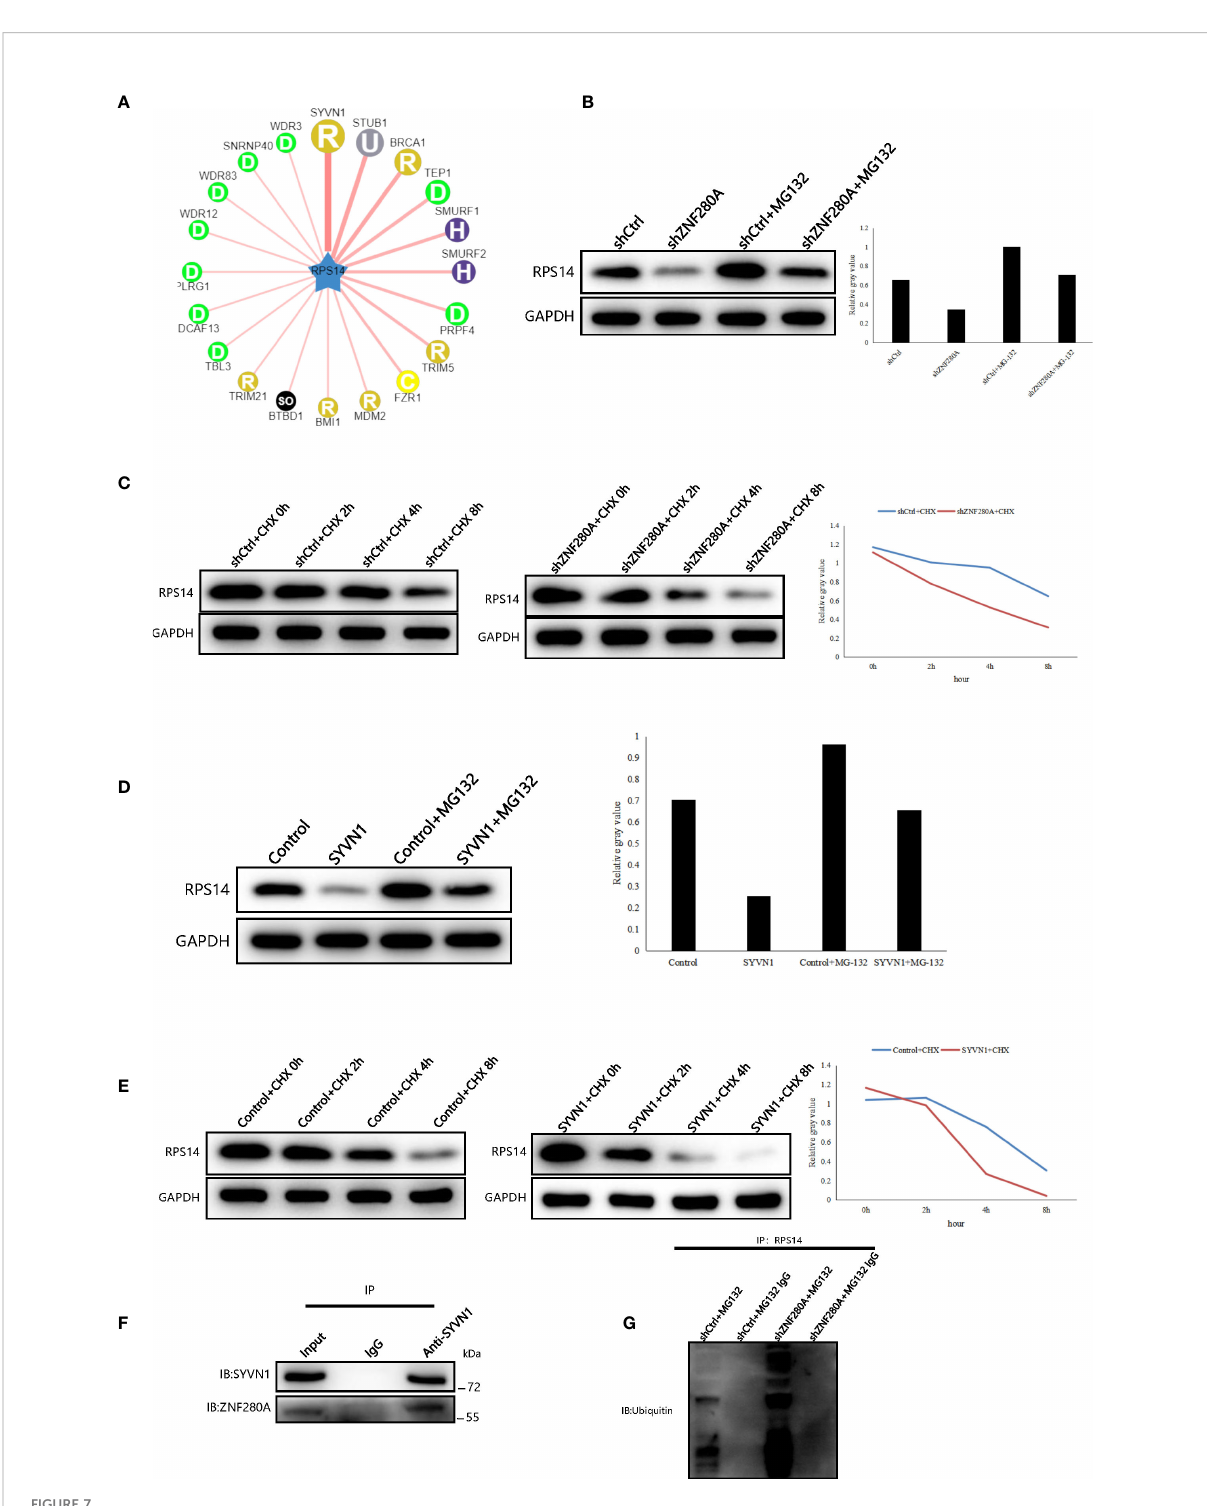
FIGURE 7 ZNF280A knockdown promotes the ubiquitination and degradation of RPS14 (A) Network view of predicted E3 ubiquitin ligases in UbiBrowser web services. In network view, the central node is the queried E3 substrate, and the surrounding nodes are the predicted ubiquitin ligases. The width of the edge re fl ects the con fi dence of the interaction. (B – E) Western blotting of RPS14 expression in the indicated cells. (F, G) Co-immunoprecipitation was applied to detect the interaction of SYVN1 and ZNF280A (F) , as well as the regulation of ZNF280A on ubiquitination of RPS14 (G)